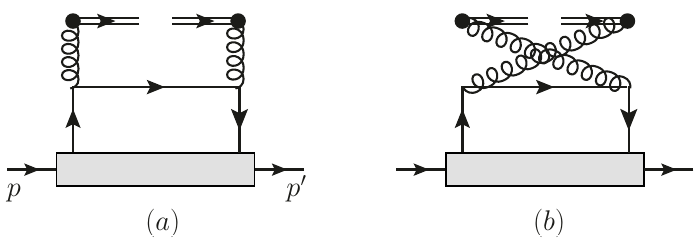
Figure 5 . The one-loop diagram for quasi GPDs. It represents contributions from quark